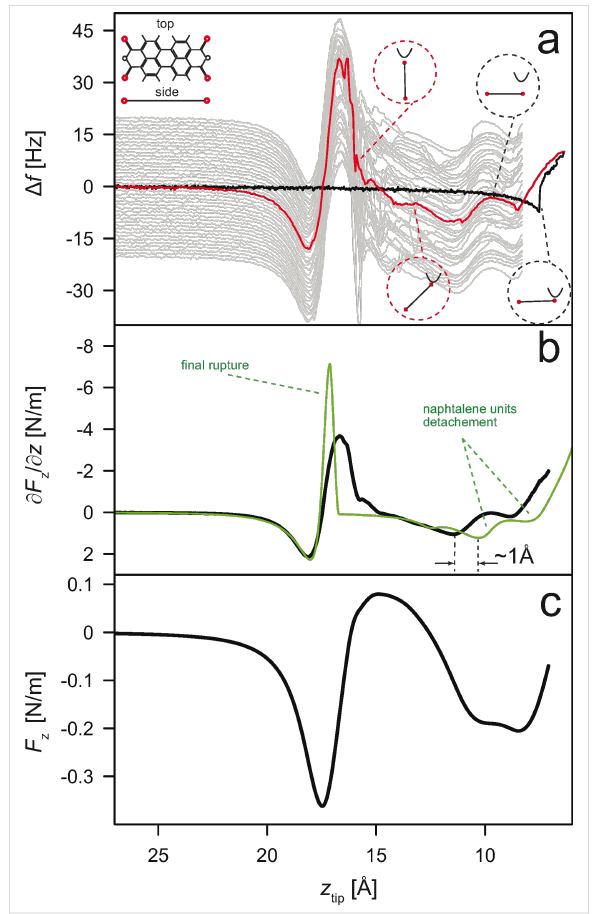
Figure 1: (a) Exemplary data from an experiment in which a single PTCDA molecule on the Au(111) surface was contacted, lifted up and put down again. The number of executed “lift–put” cycles is 40. The surface is located on the right. The black curve shows the initial ap- proach and the contacting event. The first lift curve is shown in red. The consequent “lift–put” curves are shown in grey. The “lift” (“put”) curves are shifted up (down) for clarity. The inset in the upper left corner shows the chemical structure of PTCDA. (b) Generic ∂ F z / ∂ z ( z ) curve (black) for the lifting of PTCDA from Au(111) as obtained by averaging over seven individual contacting experiments. The green curve shows the result of simulations reported in [11]. (c) F z ( z ) force curve as obtained by direct integration of the experimental ∂ F z / ∂ z ( z ) shown in panel (b) in